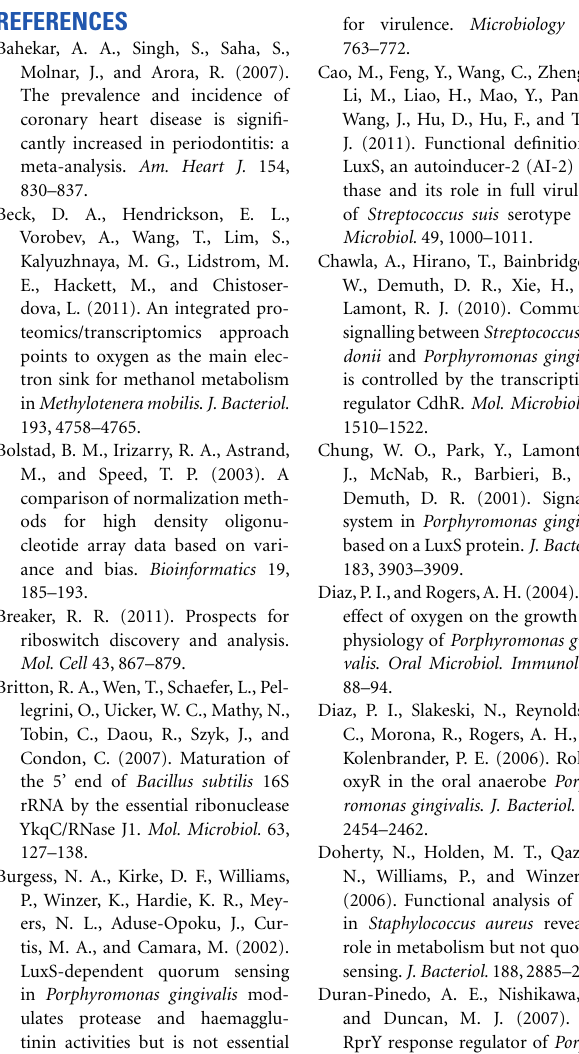
Table S1 | RNA-Seq coverage statistics by RPKM. Table S2 |Transcript abundance inWT samples sorted by RPKM. Table S3 | Hypothetical proteins expressed in eitherWT or ∆ luxS strain. Table S4 | Intergenic transcripts sorted byWT reads (large to small). Table S5 | Primers used in this study. Figure S1 | RNA-Seq results of all P. gingivalis genes. Relative gene expression levels of three replicates each for theWT and ∆ luxS mutant strains summarized in log 2 ratio with p -value.Yellow bars extending to the left or right